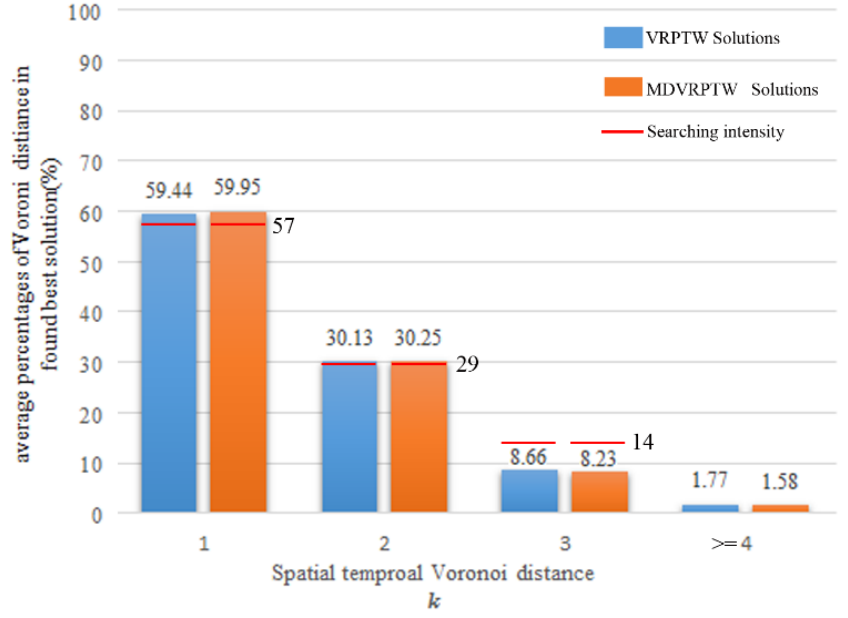
Figure 11 . Average percentage of the Voronoi distance in the best found